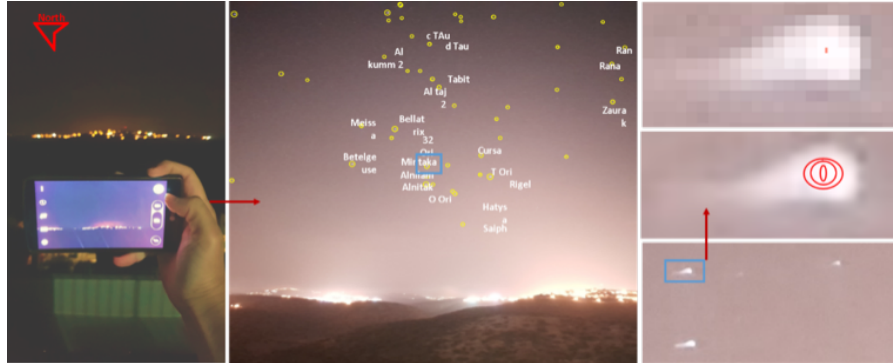
Figure 1. The star tracking algorithm on Mobile smart phone. Left : step 1: capture an image of the night sky via smartphone. Right : step 2: the image processing algorithm identify the stars pixels centroid in the image in super resolution. Middle : star identification phase—naming the stars according to the star catalog. Lastly, calculate the Image angle from the north-orientation (red arrow). Note that the image was taken while holding the phone with the relatively long exposure leading to blur effect as shown on the